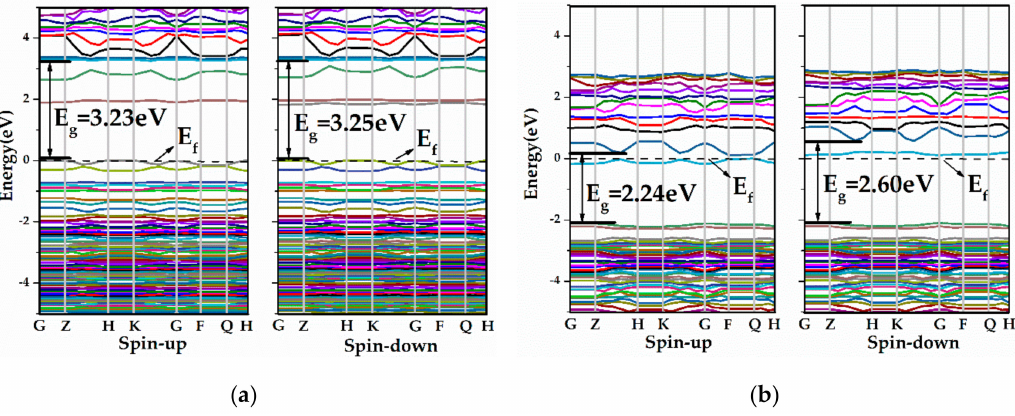
Figure 6. The band structures of ( a )Y-V Zn -ZnO, ( b ) Y-V O